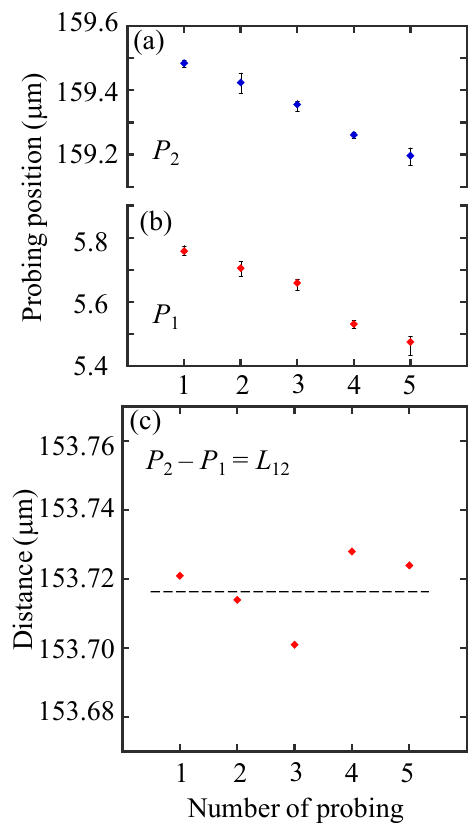
Figure 14. Experimental results of on ‐ line qualification procedure: ( a ) Probing results at P 2 ; ( b ) Probing results at P 1 ; ( c ) Measurement results of L 12 .